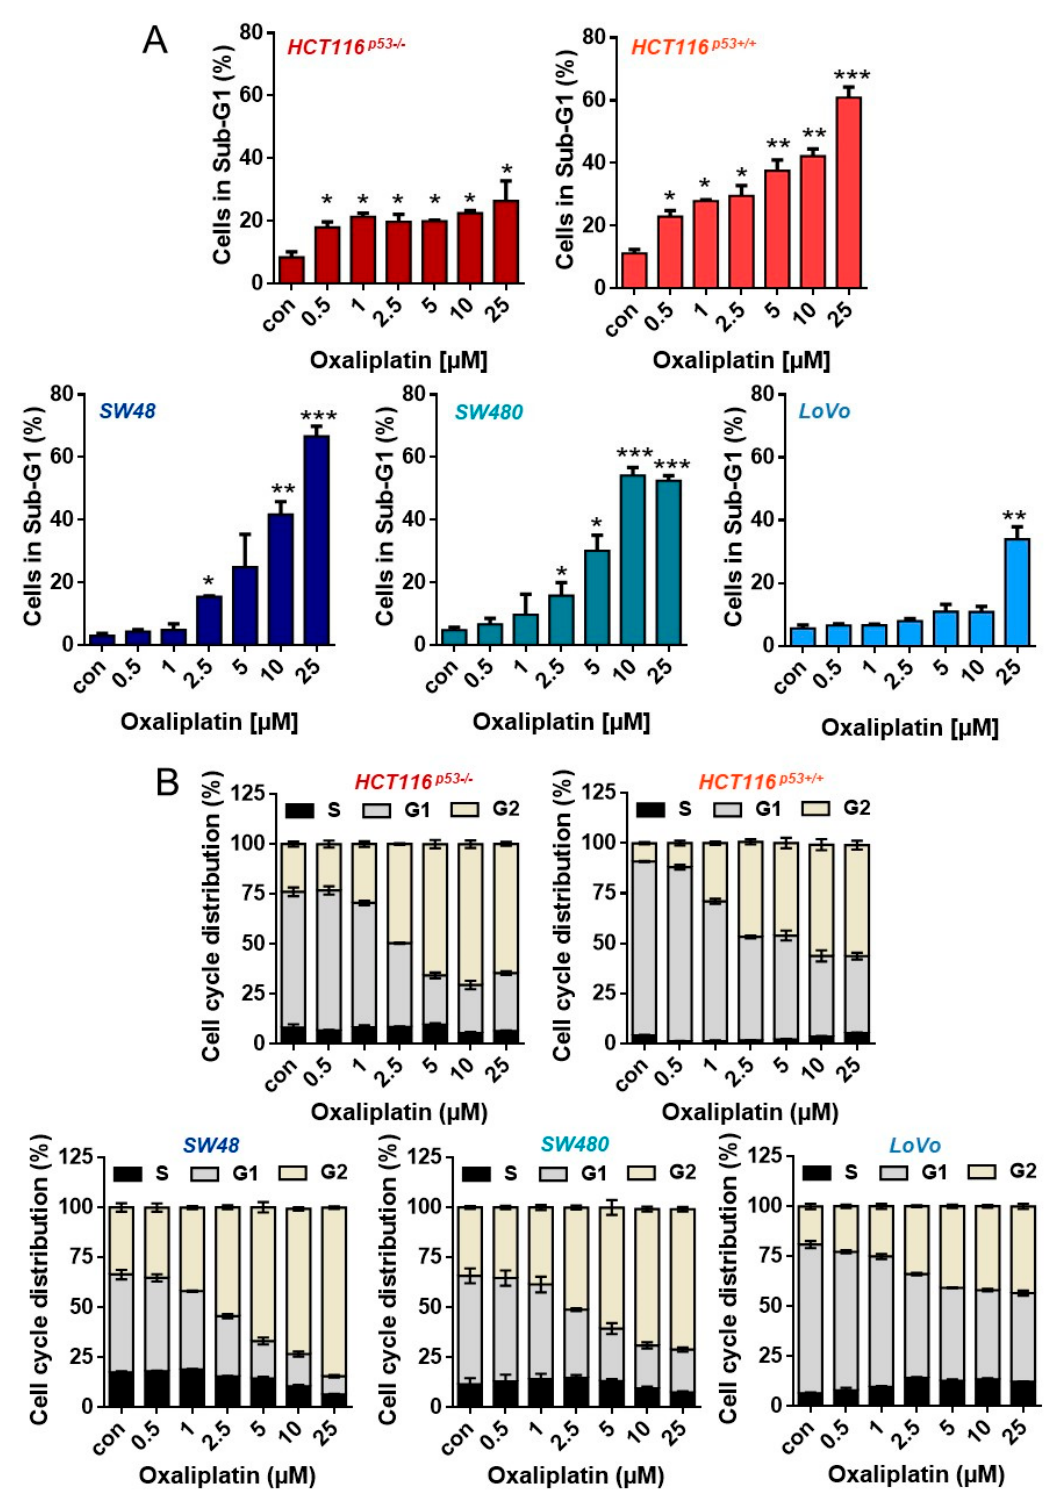
Figure 1. ( A ) Cell death and ( B ) cell cycle distribution was measured by flow cytometry 96 h upon exposure to different concentrations of oxaliplatin in PI-stained CRC cells. Experiments were performed in triplicates and differences between treatment and control were statistically analyzed using Student’s t test (not labeled = not significant, * p < 0.1 ** p < 0.01, *** p < 0.001). Concerning cell cycle distribution, at concentrations > 2.5 µ M, a significant (* or **) decrease of cells in G1 and increase in the G2-phase was observed.